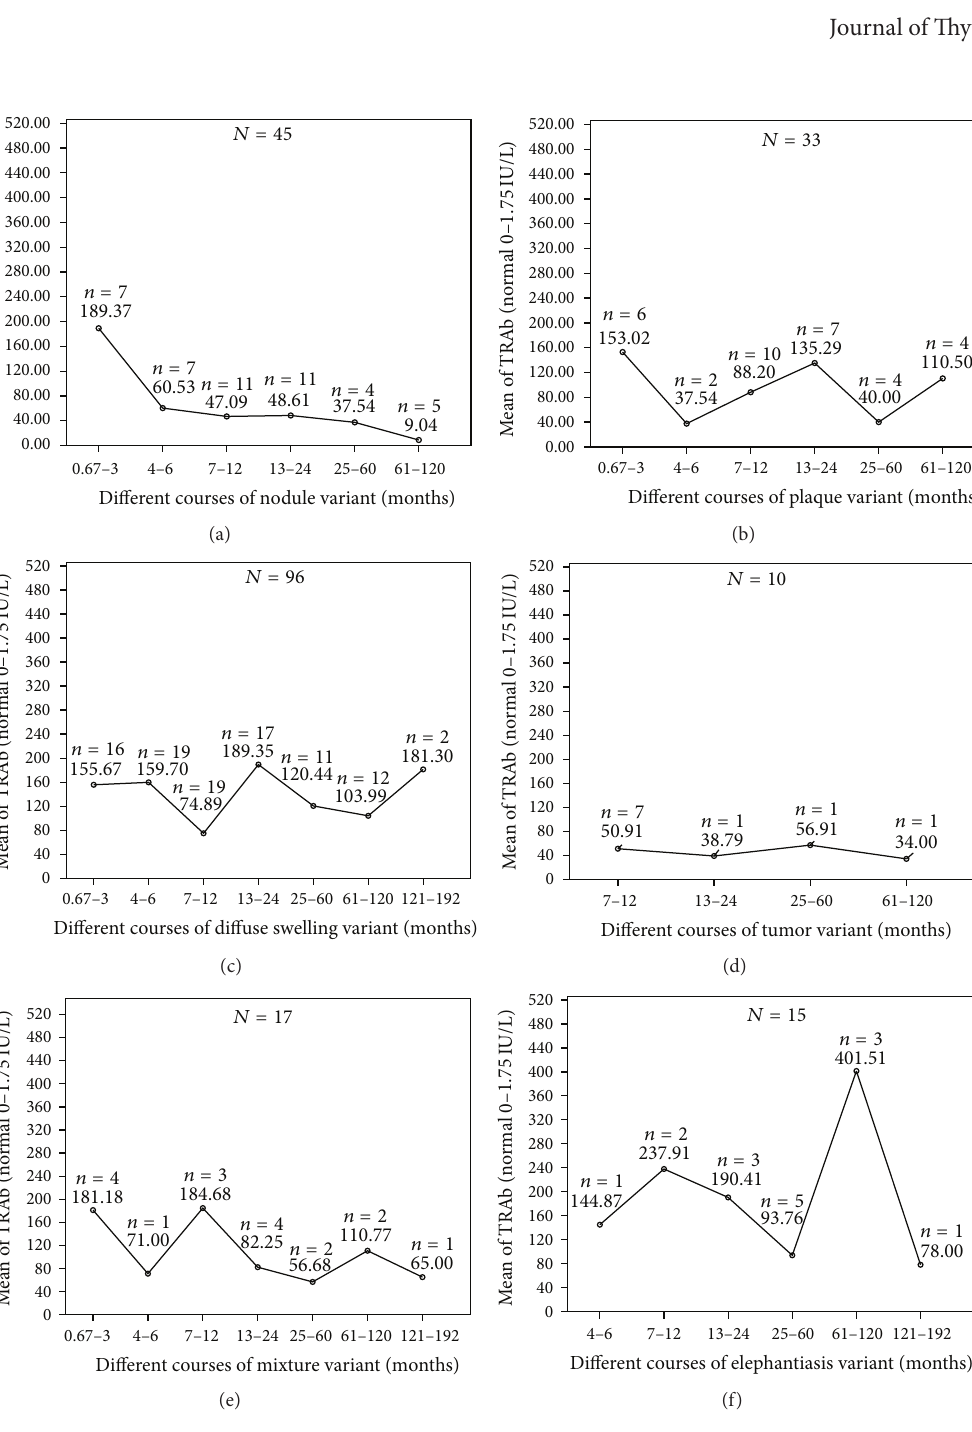
Figure 15: Trends of serum TRAb levels with the extension of their courses in 6 PTM variants of 216 cases. (a) In nodule variant, means of serum TRAb titers invariably decreased from 189.37 IU/L at 0.67–3 months to 9.04 IU/L at 61–120 months in the course. (b) In plaque variant, means of serum TRAb titers fluctuated with the extension of course. The lowest titers were 37.5 IU/L at 4–6 months and 40 IU/L at 25–60 months, respectively, and the highest titers were 153.02 IU/L at 0.67–3 months, 135.29 IU/L at 13–24 months, and 110.5 IU/L at 61–120 months, respectively.Therewasnodecreasingtrendofautoimmuneactivitywiththeextensionofcourse.(c)Indiffuseswellingvariant,meansofserum TRAb titers fluctuated with the extension of course. The lowest points were 74.89 IU/L at 7–12 months and 103.99 IU/L at 61–120 months. The highest points were 159.7 IU/L at 4–6 months, 189.35 IU/L at 13–24 months, and 181.3 IU/L at 121–192 months. (d) In tumor variant, means of serum TRAb titers fluctuated with the extension of course. (e) In mixture variant, means of serum TRAb titers fluctuated from 181.18IU/L at 0.67–3 months to 65 IU/L at 121–192 months. (f) In elephantiasis variant, means of serum TRAb titers dramatically fluctuated with the extension of course. The lowest points were at 25–60 months and 121–192 months of course and the highest points were at 7–12 months and 61–120